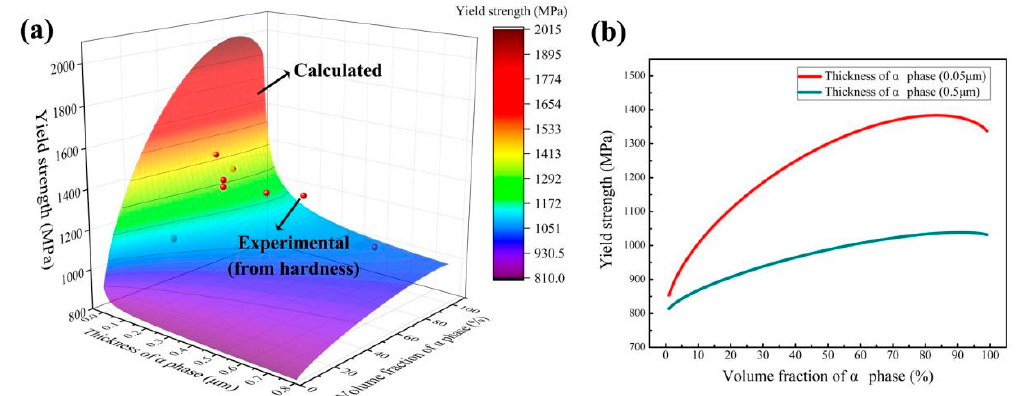
Figure 12. ( a ) Variation of the calculated alloy yield strength with α phase thickness and volume fraction (calculated using Equation (5)), and the experimental results is obtained by proportional conversion based on the proportional relationship between the yield strength and hardness of the existing tensile specimens. ( b ) Variation of yield strength with volume fraction of the α phase for α phase thicknesses of 0.05 and 0.50 μ m.